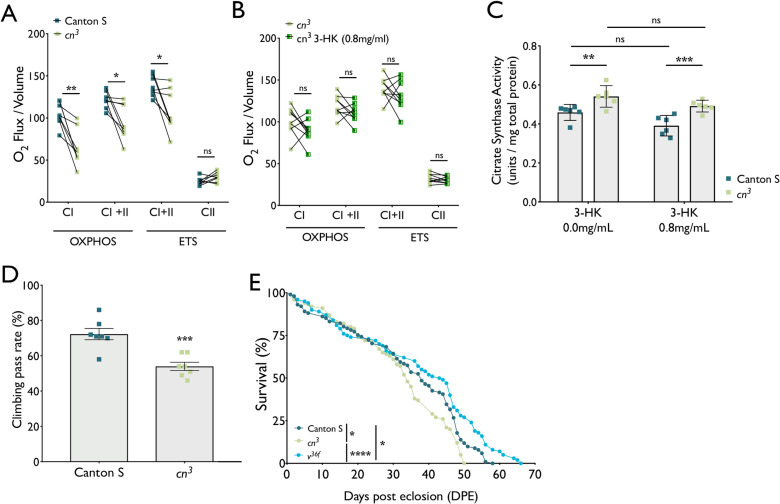
Changes in TCA cycle, OXPHOS, locomotor ability and lifespan in cn3 flies.(A) Respiratory capacity is reduced in cn3 mutants flies. (mean ± SEM; paired t test, Holm-Sidak post hoc, ** P < 0.01, * P < 0.05, n = 8). (B) 3-HK supplementation does not rescue cn3 respirometry phenotypes (mean ± SEM; paired t test, Holm-Sidak post hoc, ns = not significant, n = 9) (C) Citrate synthase activity is increased cn3 amorphs even when supplemented with 3-HK (mean ± SEM; two-way ANOVA, Tukey post hoc, ** P < 0.01, *** P < 0.001, ns = not significant, n = 6). (D) Climbing ability is reduced in cn3 mutants (mean ± SEM; student t-test, *** P < 0.001, n = 6). (E) Longevity is recued in cn3 but enhanced in v36f mutants (n = 100, Mantel-Cox test, * P < 0.05, **** P < 0.0001).